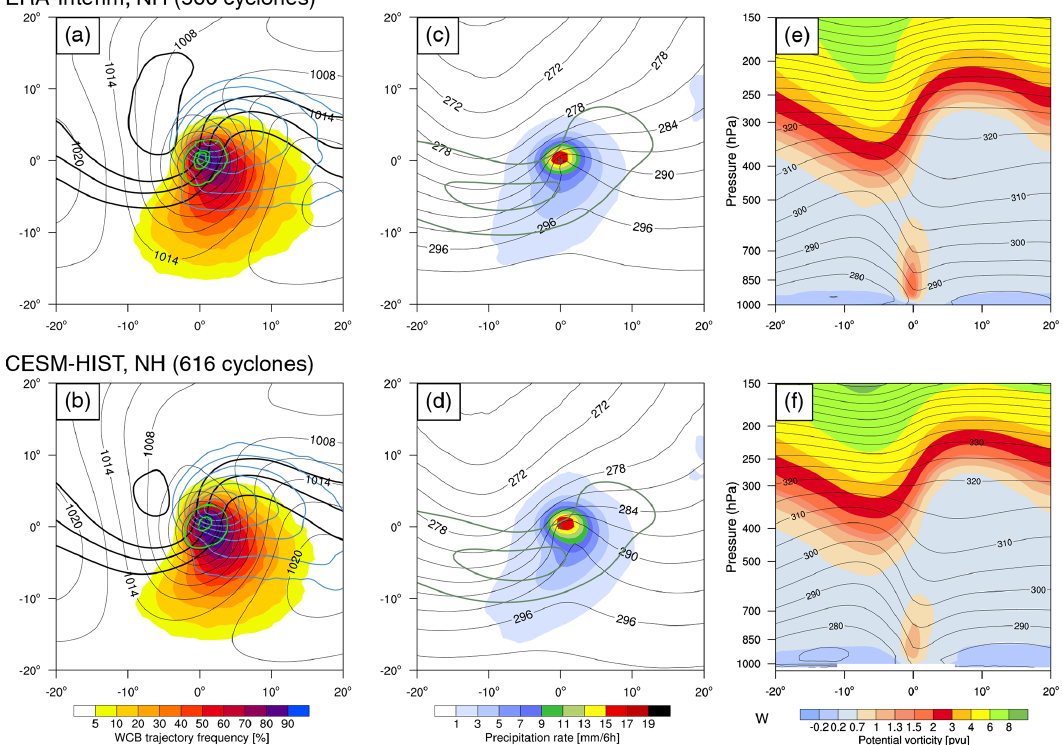
Figure 3. Composites of C1 cyclones in NH winter in (a, c, e) ERA-Interim and (b, d, f) CESM-HIST in the middle of the 24h period of strongest deepening. (a, b) Frequency of WCB air parcels with p > 500hPa (%; shading) and p < 500hPa (blue contours at 5%, 10%, 20%, 30%, ... , 80%) and WCB air parcels with PV > 1pvu and 900 > p > 700hPa (green contours at 10%, 50%, and 60%), SLP (thin black contours every 3hPa), and PV at 250hPa (thick black contours at 2, 3, 4, and 6pvu). (c, d) The 6h accumulated precipitation (mm; shading), potential temperature at 850hPa (black contours every 3K), and wind speed at 250hPa (green contours at 50 and 60ms − 1 ). (e, f) West–east-oriented cross section across the centre of the composite cyclone, showing PV (pvu; shading) and potential temperature (black contours every